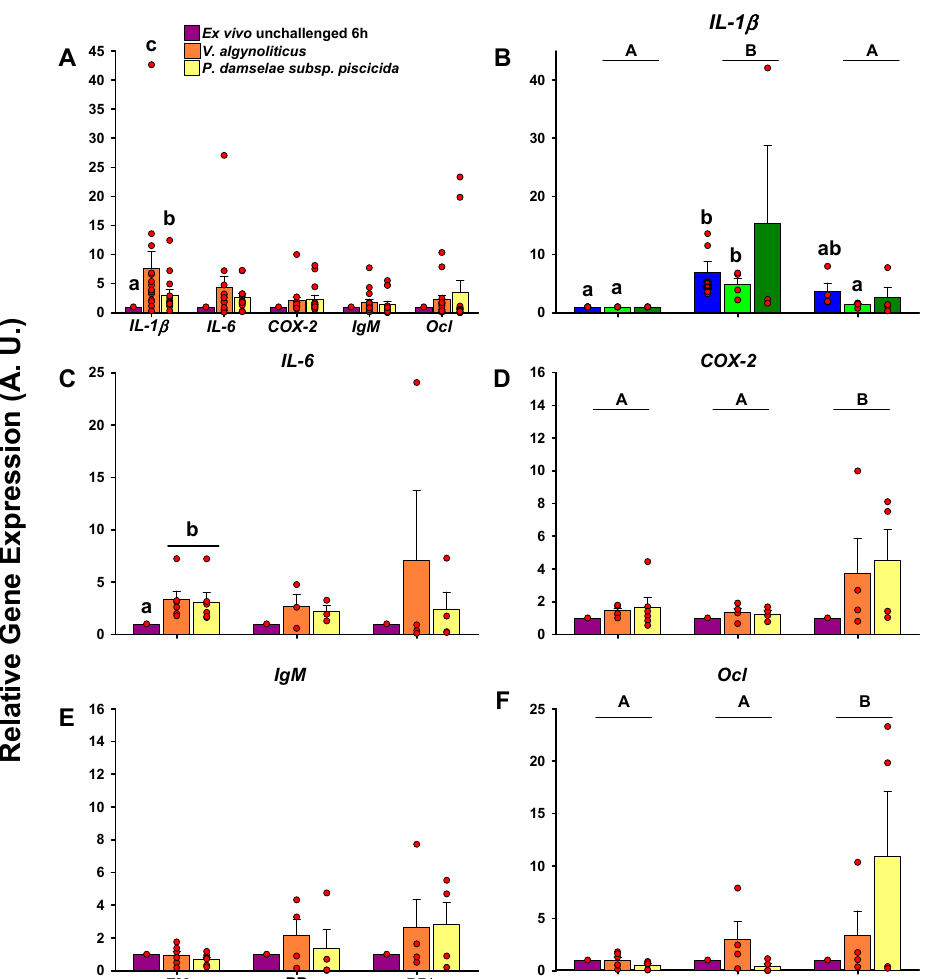
Figure 5. The e ff ect of bacterial challenge based on diet after ex vivo bacterial exposition in Phase II (250 g). Relative gene expression (A.U.) of the di ff erent genes is expressed by the mean and standard error. Capital letters indicate di ff erences between diets, meanwhile lowercase letters indicate di ff erences between bacteria for each gene ( p < 0.05) after 6 h of incubation. ( A ) The e ff ect of bacterial challenge independent of diet. Gene expression of ( B ) IL-1 β , ( C ) IL-6, ( D ) COX-2 , ( E ) IgM , and ( F ) Ocl based on the stimuli and diet. Sample data in each experimental group are represented by red